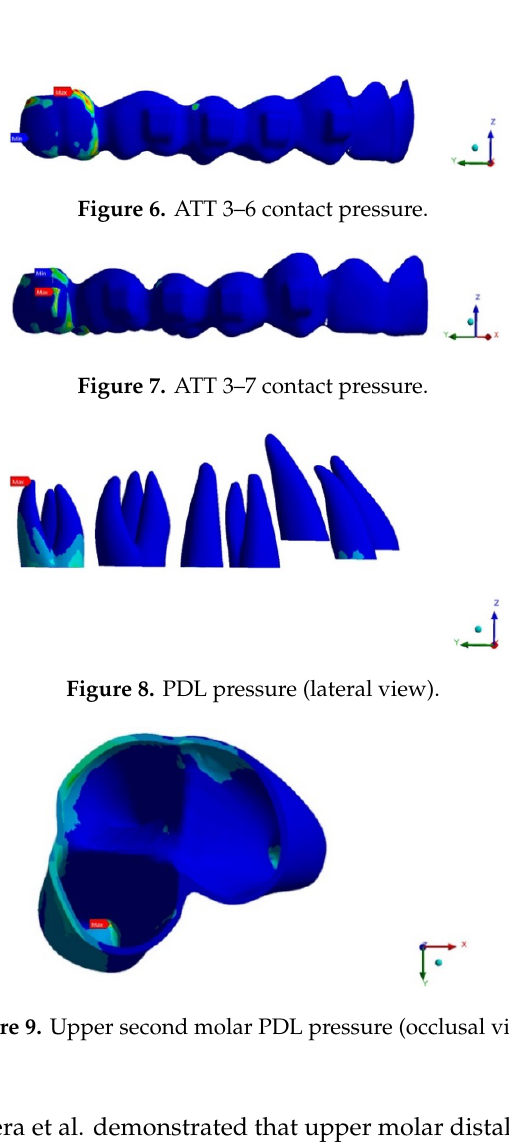
Figure 1. NO ATT tooth displacement. Figure 2. ATT 3–6 tooth displacement. Figure 3. ATT 3–7 tooth displacement. Figure 4. Aligner deformation.